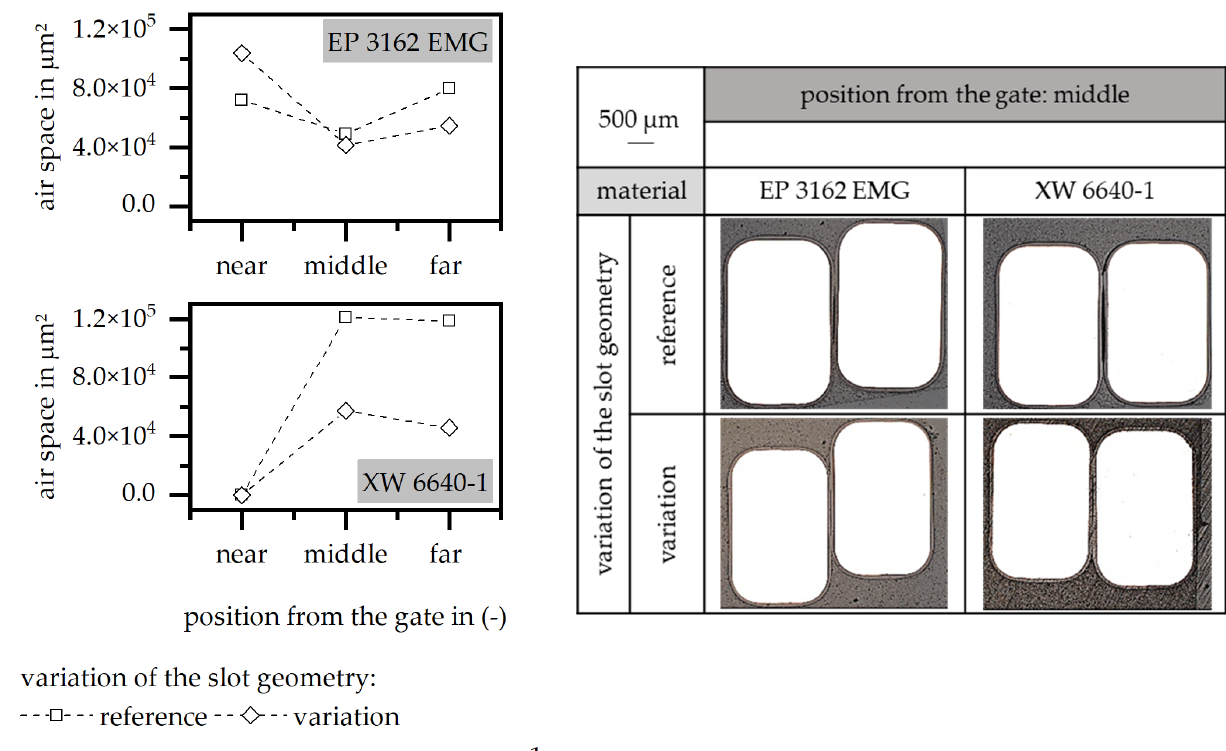
Figure 16. Airspace and position of the wire relative to the stack, relative to the variation in the slot geometry and flow-improving grooves in the insulation system.